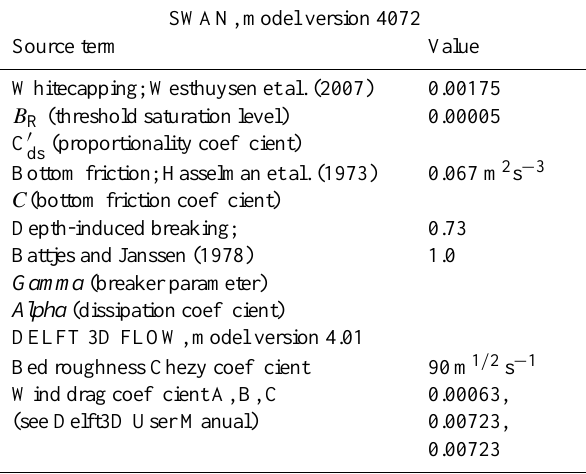
Table 3. Model version and parameter